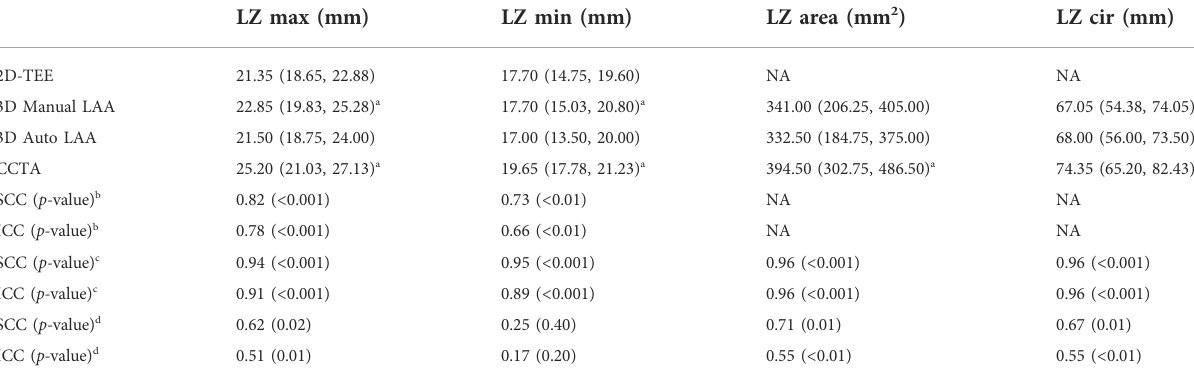
TABLE 2 Comparison of 2D-TEE, 3D Manual LAA, 3D Auto LAA and CCTA for preoperative measurements of parameters related to left atrial appendage occlusion.